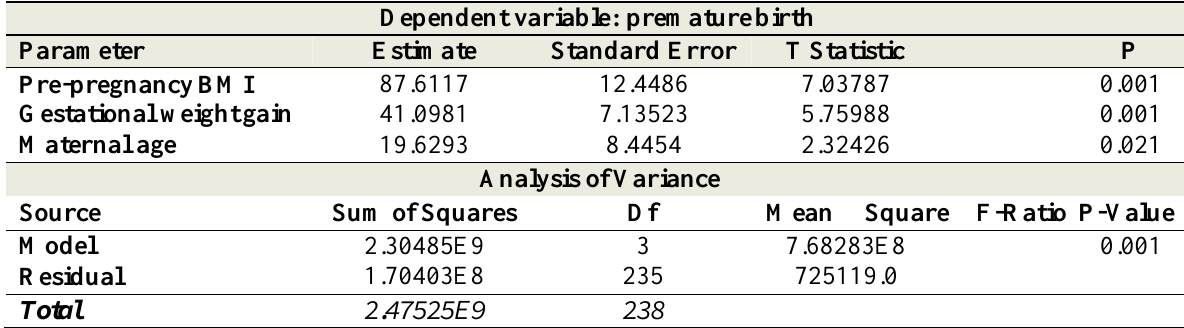
Total 2.47525E9 238 R-squared = 93.1157 %; R-squared (adjusted for d.f.) = 93.0571 %; Standard Error of Est. = 851.539; Mean absolute error = 646.141; Durbin-Watson statistic